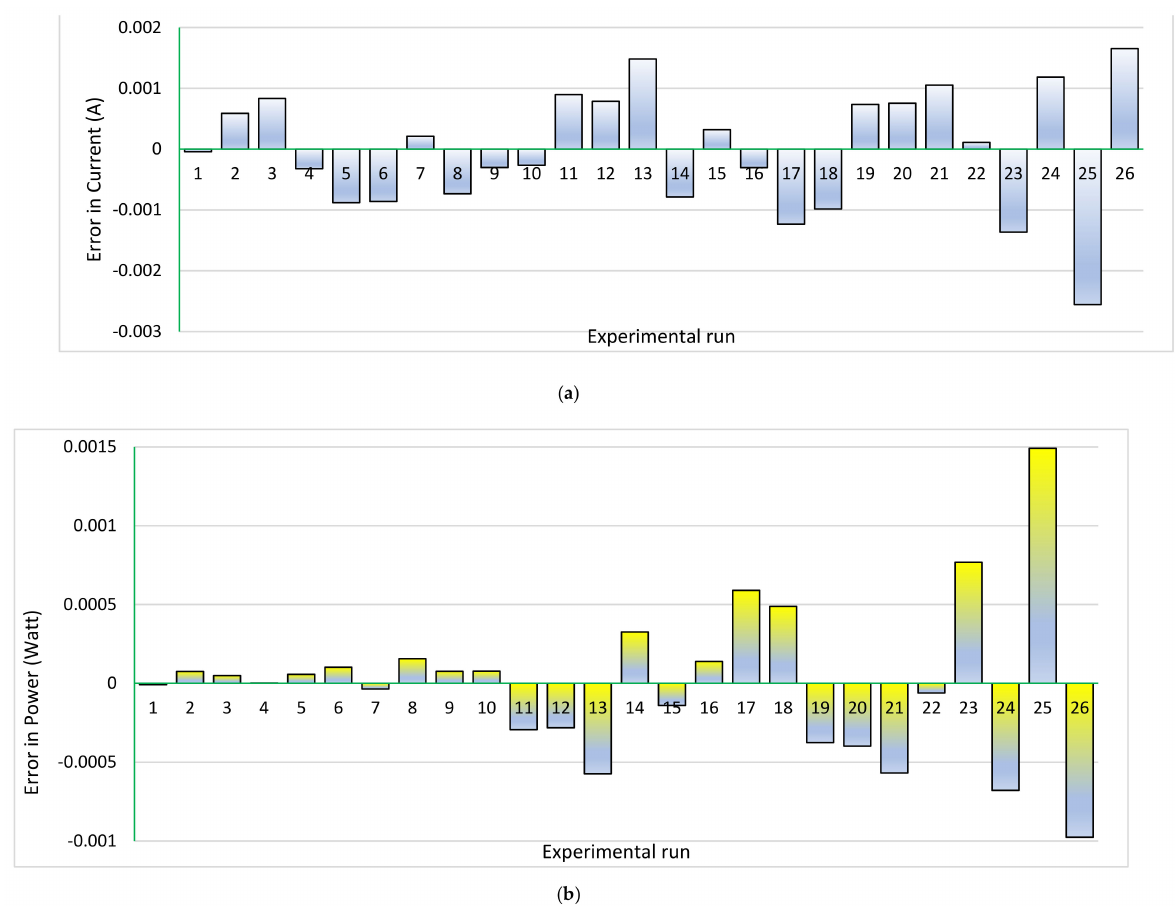
Figure 11. Error values for R.T.C. France DDM based on TFWO: ( a ) Current error values and ( b ) power error